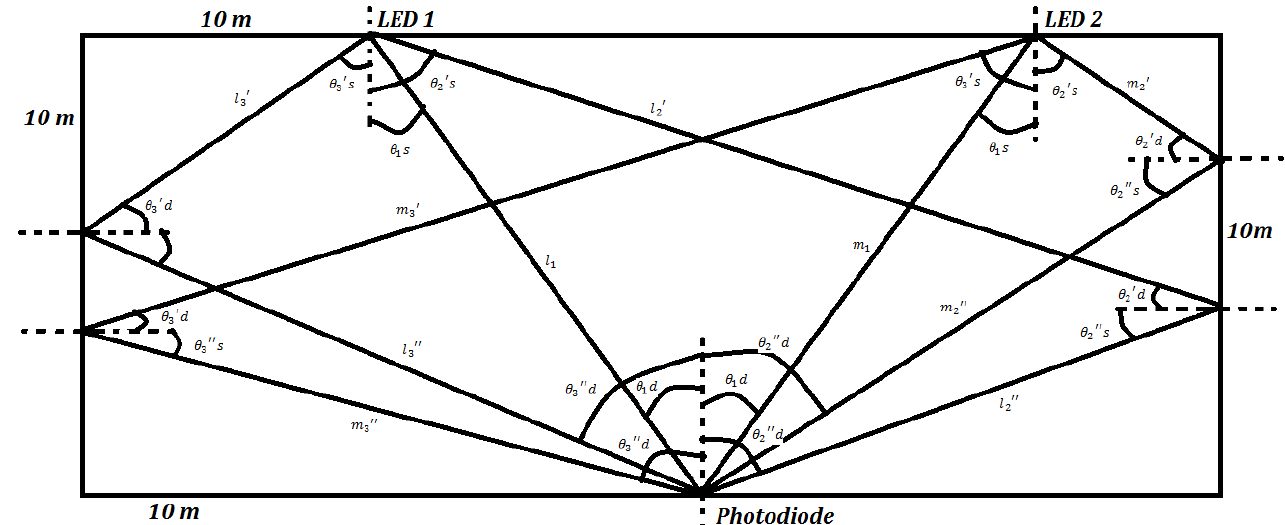
Figure 5. Experiment design for dual LED NLOS propagation model. The experiment was 10 m long and considered a single LED and photodiode with multiple refection points.